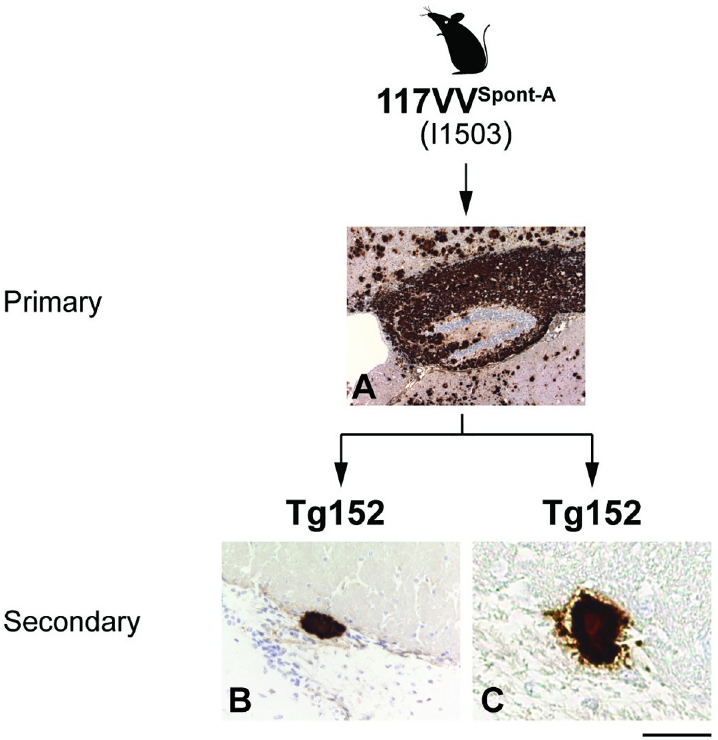
Fig 8. Immunohistochemical analyses of brain from 129VV Tg152 mice challenged with a spontaneous 117V prion isolate passaged once in 117VV Tg30 mice. IHC was performed using anti-PrP monoclonal antibody ICSM 35 (epitope human PrP residues 93–105). Panel A shows the hippocampus; panels B and C show the corpus callosum. (A) Primary transmission of a spontaneous 117V prion isolate (from 117V Spont-A mouse brain) to 117VV Tg30 mice. (B, C) Spontaneous 117V prion isolate from 117V Spont-A mouse brain was passaged once in 117VV Tg30 mice and then passaged in 129VV Tg152 mice. The mouse in panel A was culled with clinical disease at 733 days post-inoculation, and the mice in panels B and C were culled without neurological disease at 456 days post-inoculation. Scale bar, 300 μ m. ICSM, Imperial College School of Medicine; IHC, immunohistochemistry; PrP, prion protein.